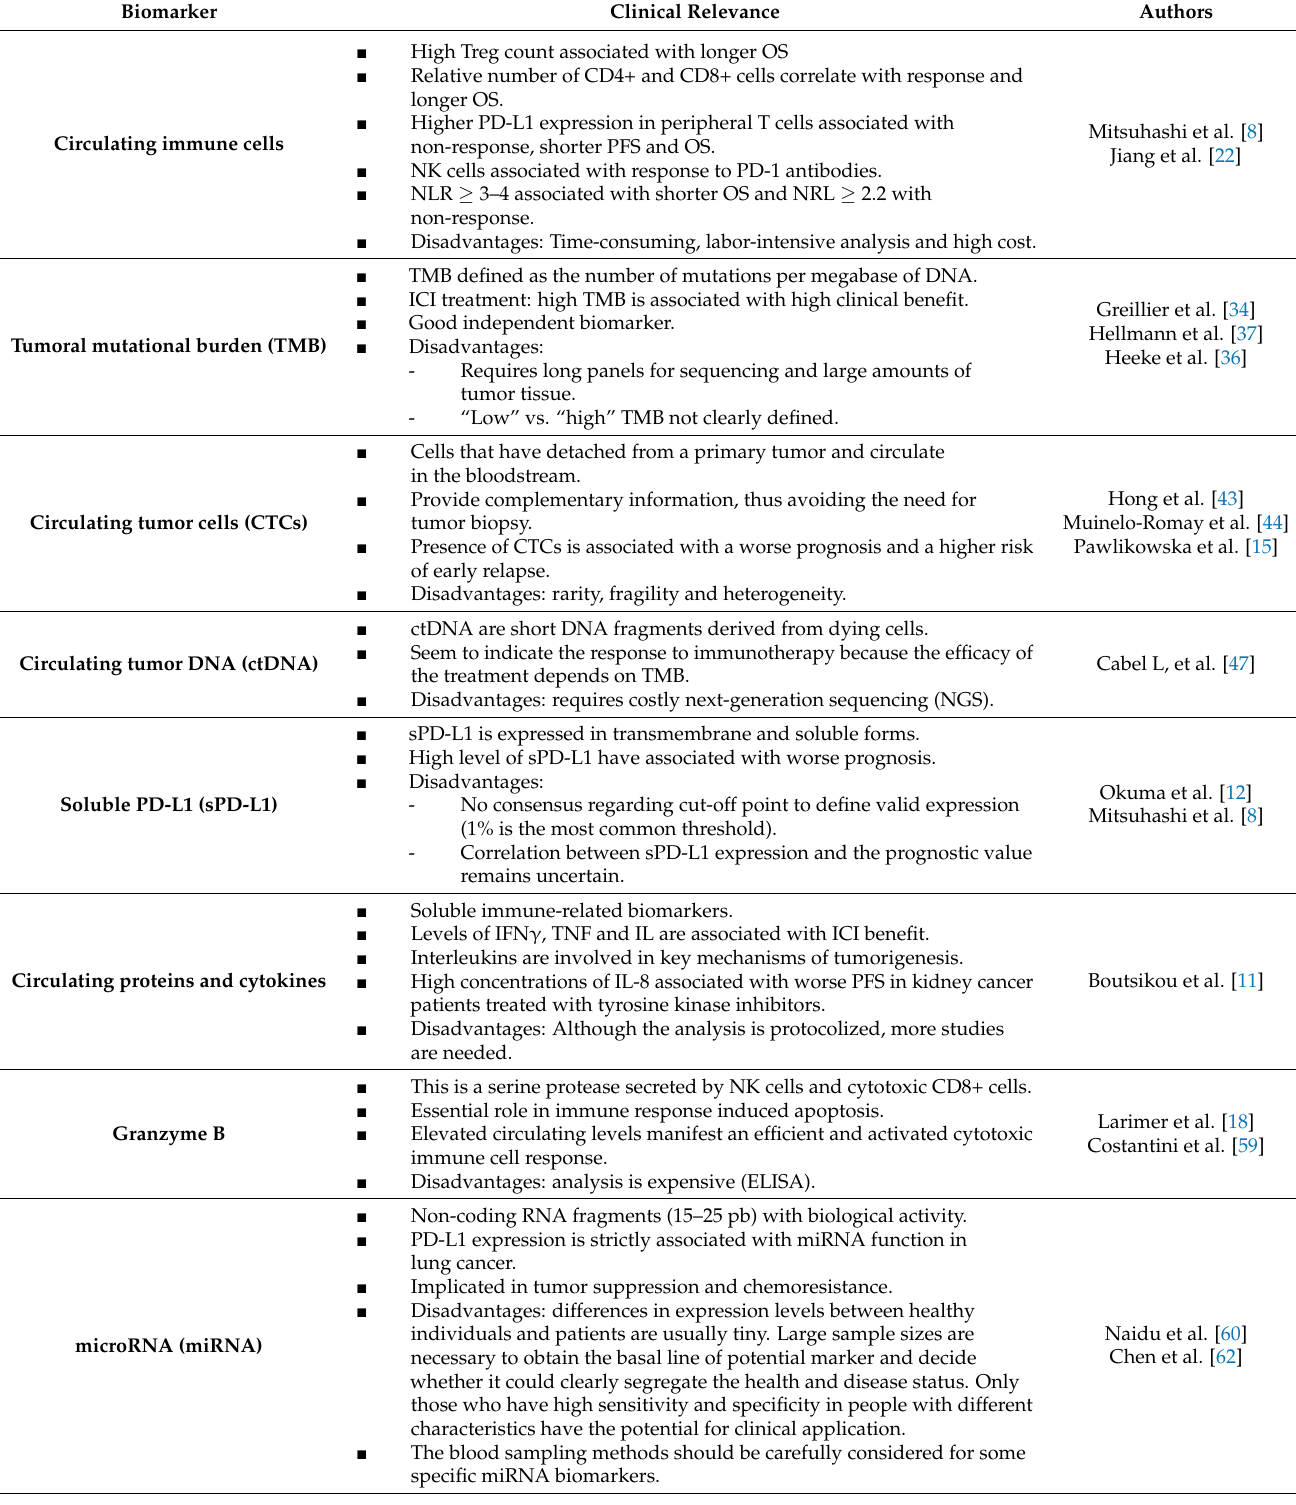
Table 1. Potential soluble biomarkers for cancer immunotherapy. Clinical